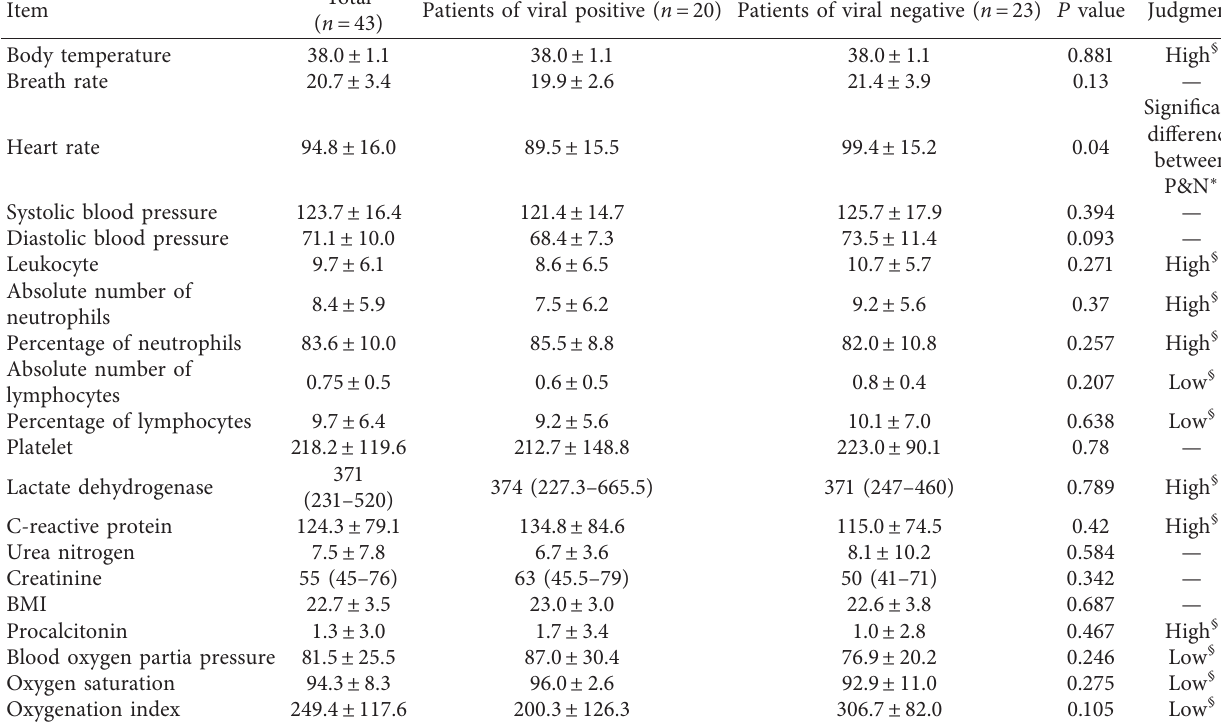
Table 3: Pathological performance.